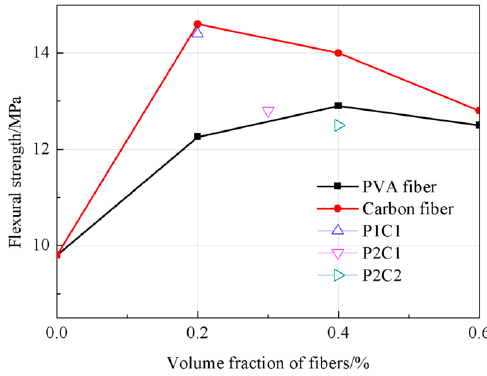
Figure 4. The tendency of the flexural strength.